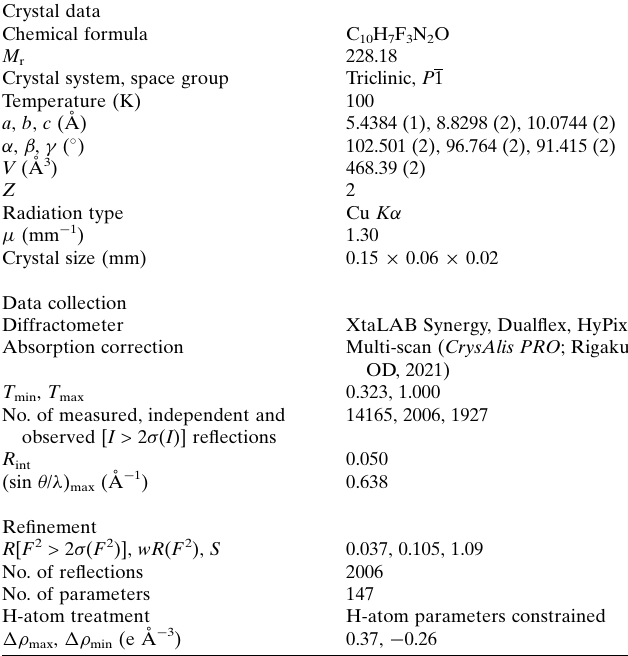
Table 3 Experimental details. Crystal data Chemical